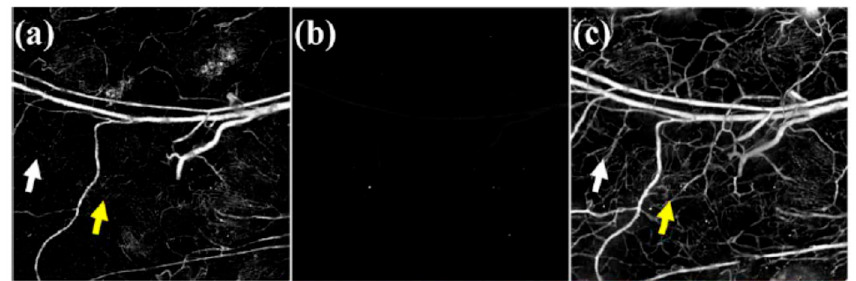
Figure 1. ( a ) Optoacoustic image of naked mouse ear before Evans blue injection at 570 nm ( b ) optoacoustic image of naked mouse ear before Evans blue injection at 610 nm. ( c ) optoacoustic image of naked mouse ear after Evans blue injection at 610 nm. Arrows indicated capillaries that become visible and continuous with Evans blue injection. Figure from [48] reproduced with permission from the publisher.